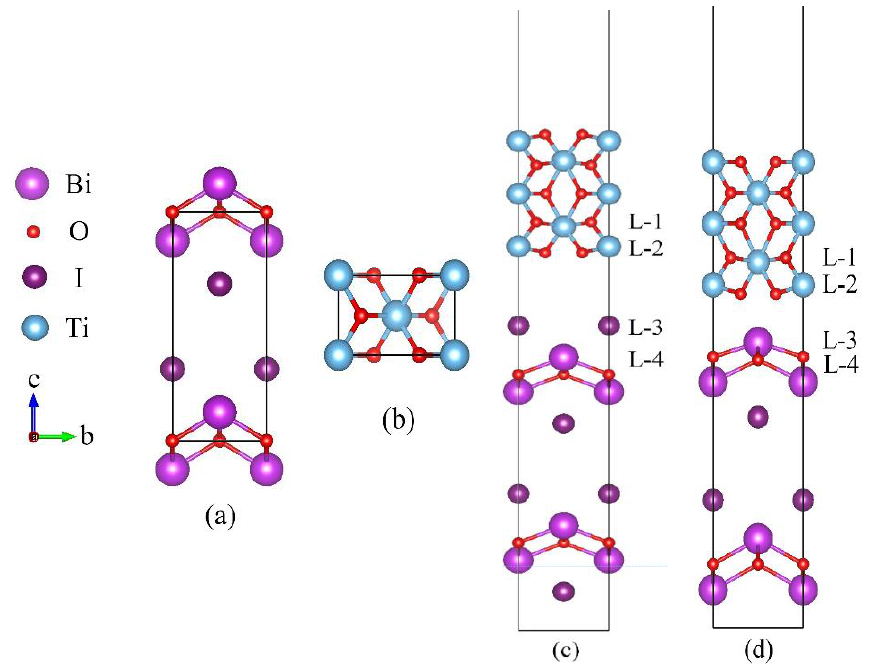
Figure 1. Crystal models: ( a ) BiOI, ( b ) rutile-TiO 2 , finally relaxed configuration of ( c ) 1I-BiOI / TiO 2 and ( d ) BiO-BiOI / TiO 2 heterojunction. Purple, red, brown and blue spheres represent Bi, O, I and Ti atoms respectively. L-1 to L-4 represent atomic layer from layer-1 to layer-4.